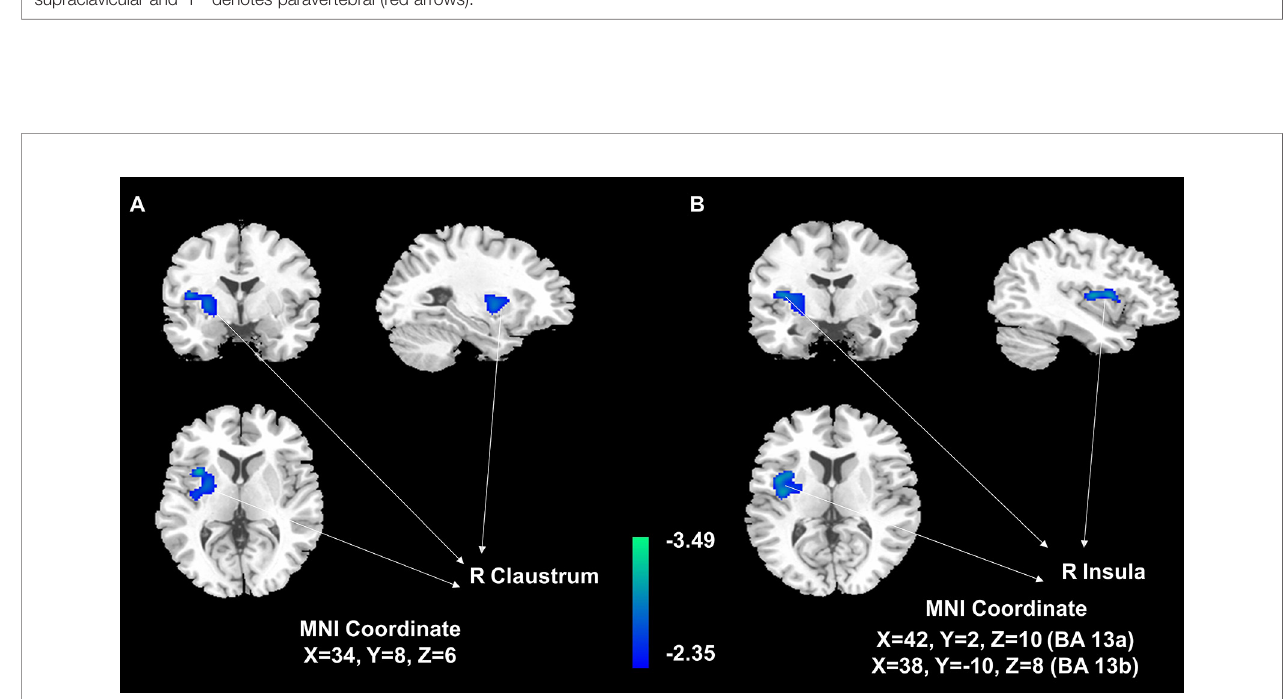
FIGURE 3 | Areas of signi fi cant differences of glucose metabolism in subjects with activated BAT, compared with controls. Statistical Parametric Mapping (SPM) results: It is displayed on a T1 template overlaid with magnetic resonance images at the threshold of uncorrected P <0. 01, threshold K>321.6, and the gray-scale fi gures are a T1 structural MRI that are representative of MNI space. The blue areas represent relatively hypometabolic regions of decreased 18 F-FDG uptake in the right claustrum (A) and right Insula (B) in BAT-positive subjects than in negative control